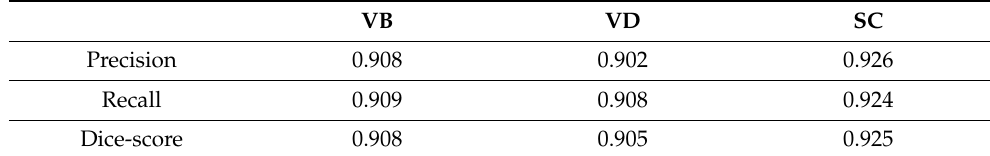
Table 2. Statistical evaluation of the AI-based segmentation of the vertebral bodies (VB), intervertebral Figure 3. T2-weighted sagittal images of the entire spine ( A ) with segmentation by the AI algorithm discs (VD) and spinal canal (SC) in comparison to the human segmentations. ( B ) of the vertebral bodies (red), intervertebral discs (green) and spinal canal (blue). Enlarged view of the lumbar spine without ( C ) and after AI segmentation ( D ).